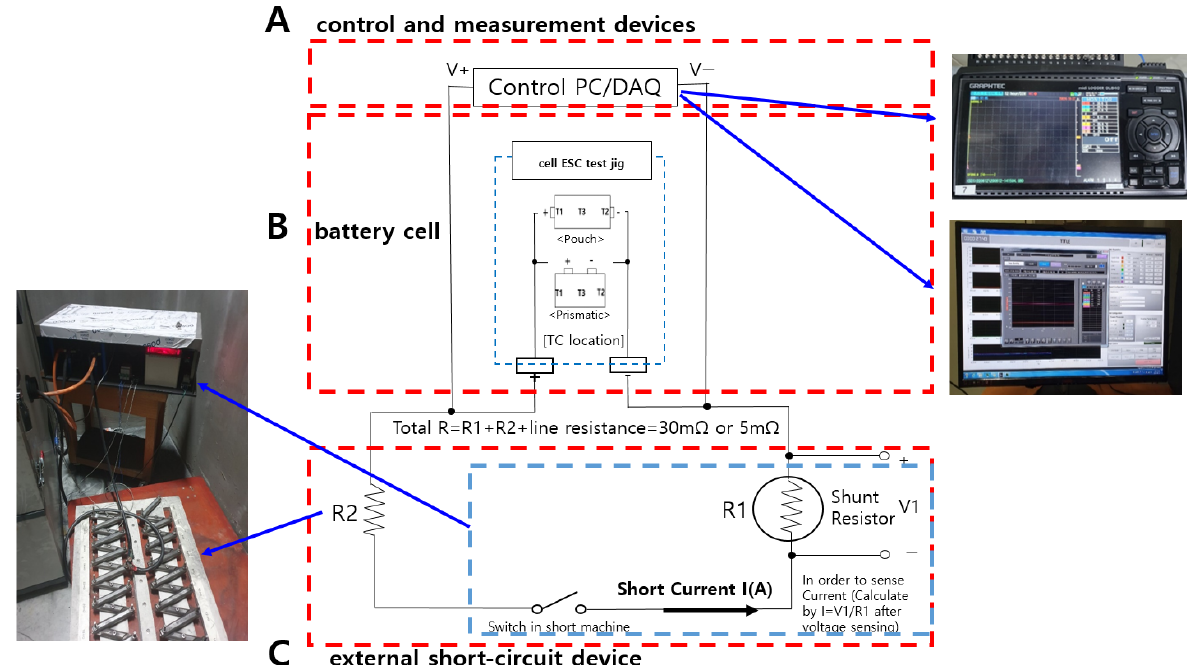
Figure 3. Configuration of test devices for battery cell.